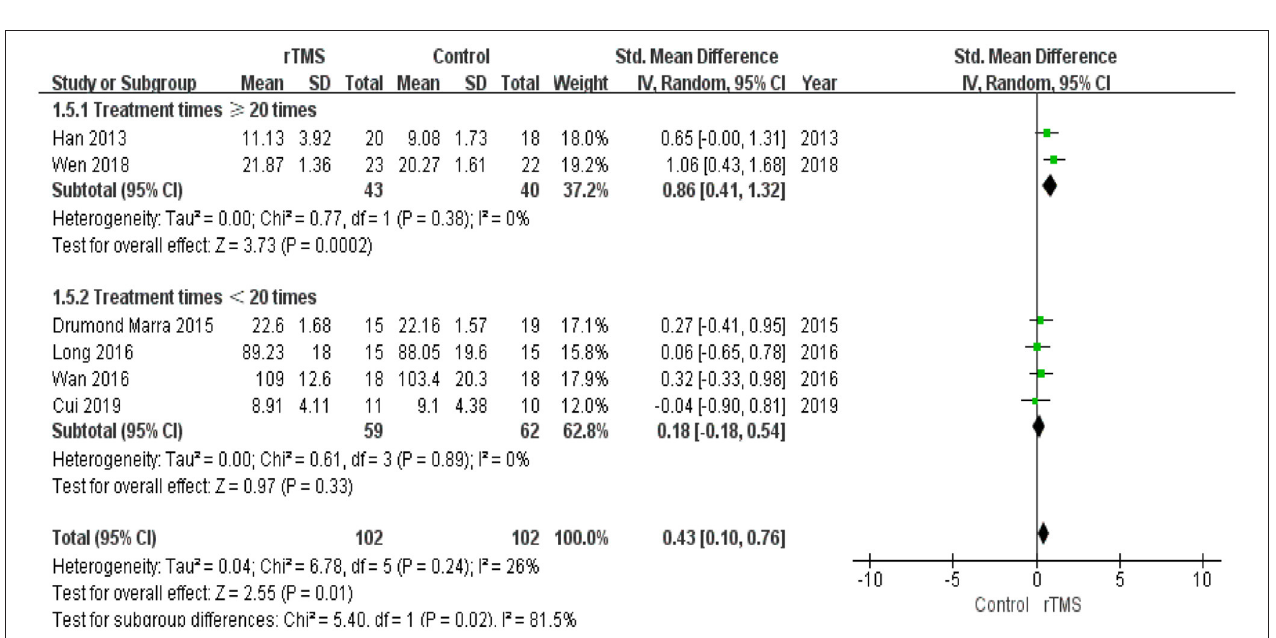
FIGURE 9 | Meta-analysis forest plot of subgroup analysis showing memory of repetitive transcranial magnetic stimulation group vs. control group in the treatment of mild cognitive impairment: high frequency stimulation vs. low frequency stimulation.